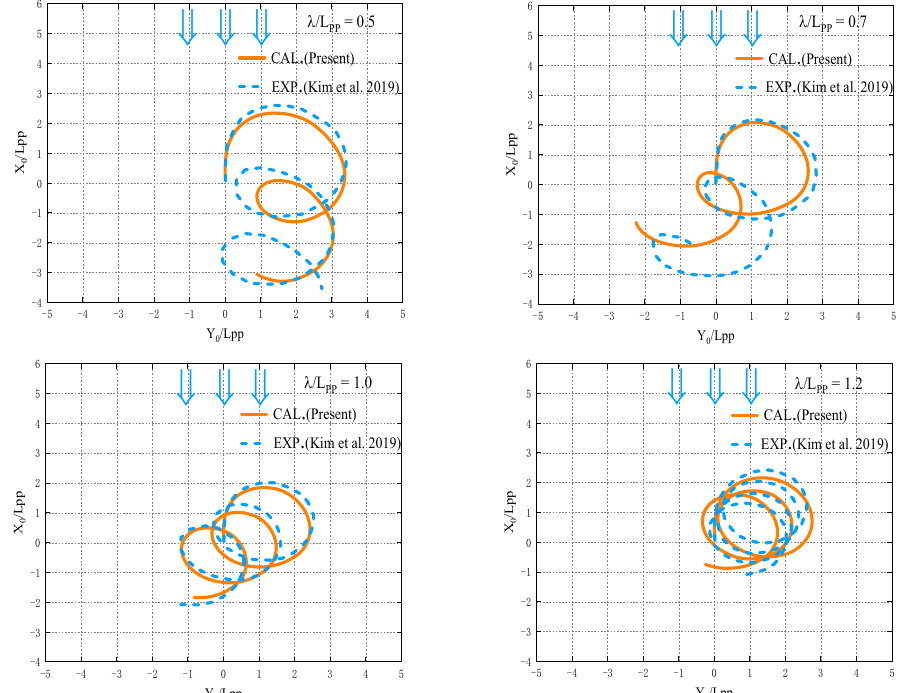
Figure 23. Comparisons of the turning trajectory of +35° turns with the wavelength variation in the head waves. The experimental values were reproduced from [8], with permission from Elsevier, 2022.